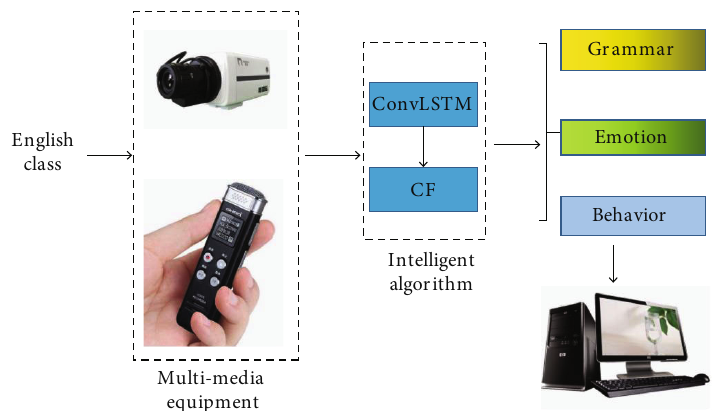
Figure 1: Design scheme of application of computer platform and multimedia technology in English teaching.